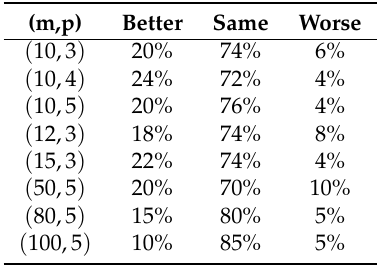
Table 1. Performance Comparison